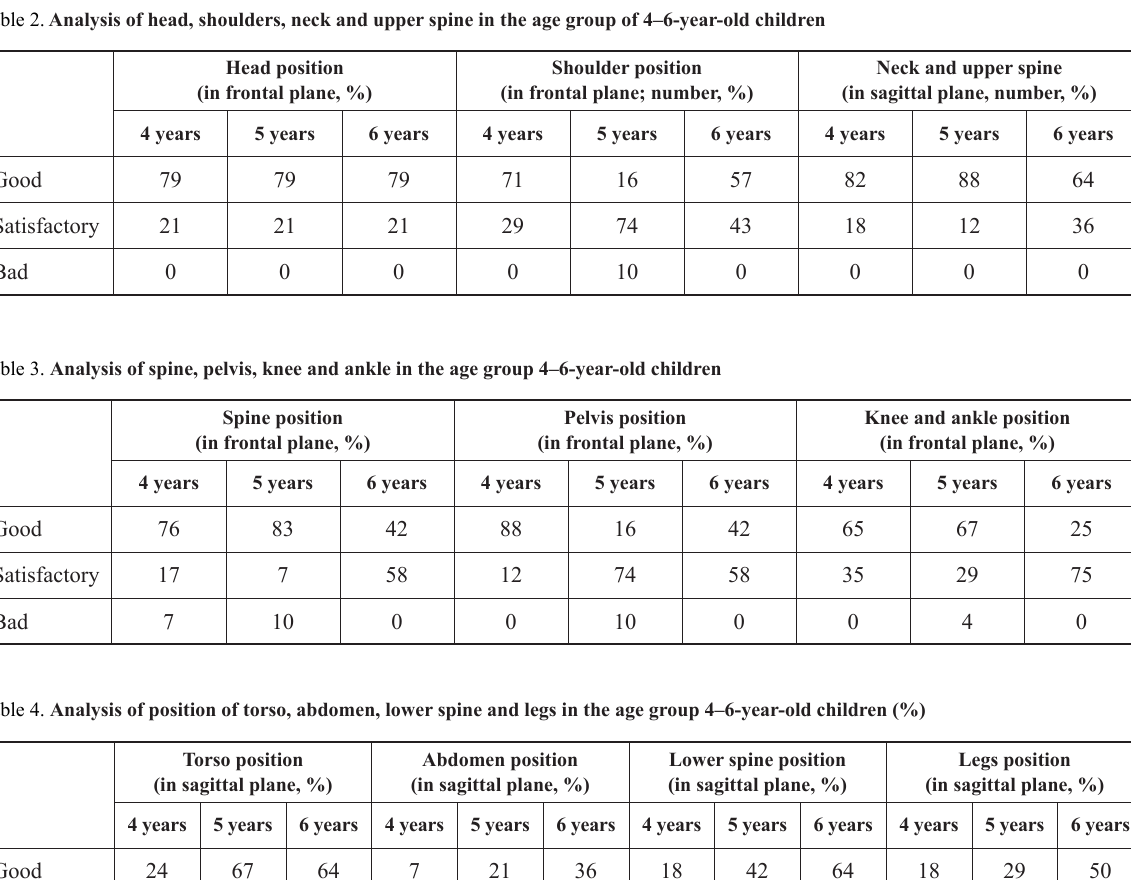
Table 2. Analysis of head, shoulders, neck and upper spine in the age group of 4–6-year-old children Head position (in frontal plane, %)